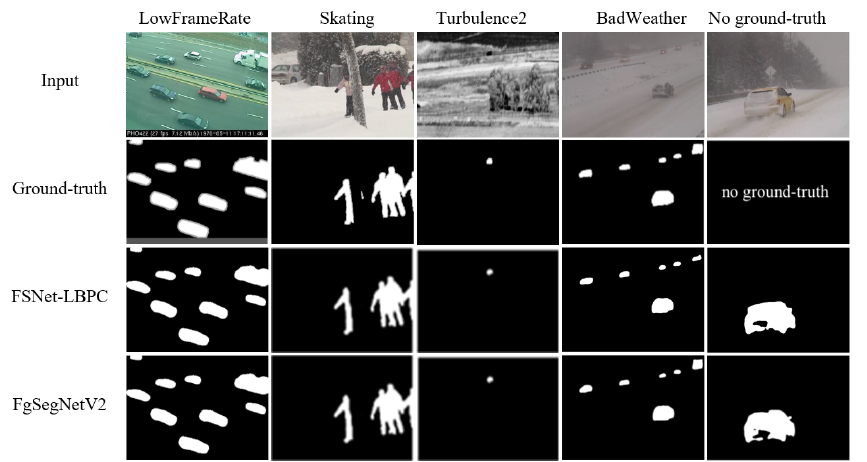
Figure 5. Qualitative comparison results on CDNet2014 [47] benchmark. The comparison method is follows: FgSegNet_v2 [9].